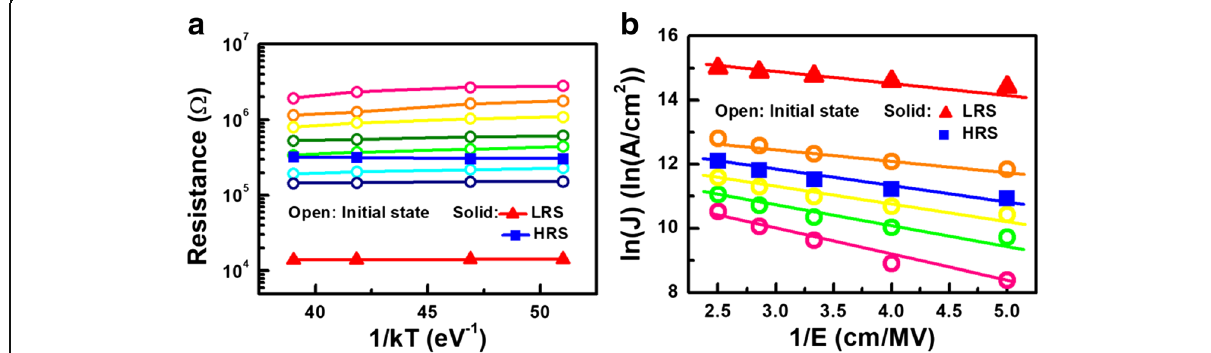
Fig. 6 Conduction mechanism of CRRAM is determined by checking a temperature dependency and b electric field dependency. Trap-assisted tunneling followed by CRRAM is believed by two conduction characteristics, weak temperature dependency and linearly fitting between ln(J) and 1/E